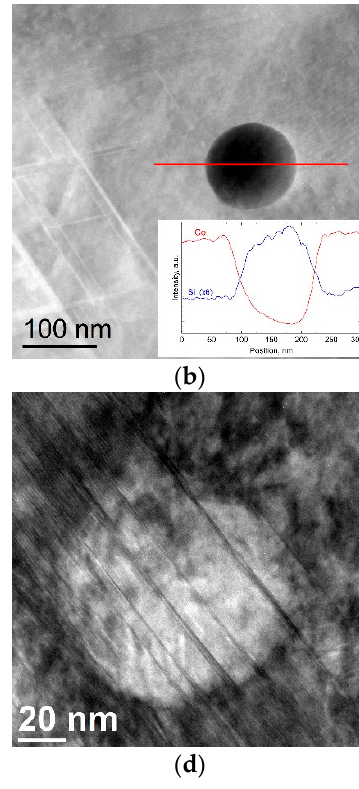
Figure 8. ( a ) STEM-HAADF image of Si-containing precipitation, the inset shows an enlargement with visible clusters of Si atoms, indicated by green arrows; ( b ) profile analysis of Co and Si exchanges; ( c ) STEM-BF image of the boundary between precipitate and matrix; ( d ) STEM-BF image of strongly deformed matrix with Si precipitate.